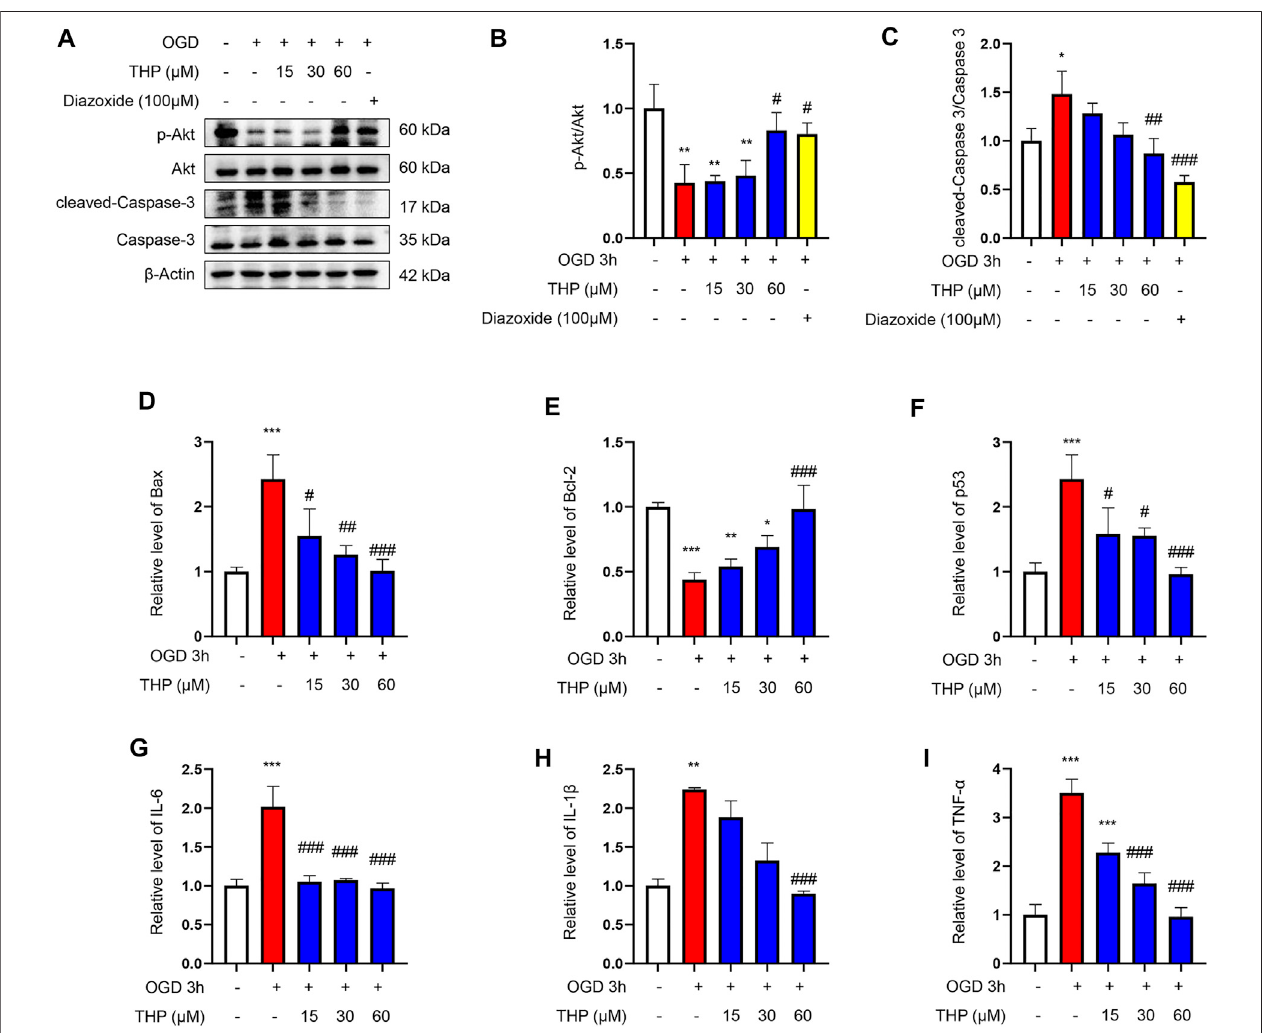
FIGURE 8 | THP was able to suppress apoptosis and the expressions of in fl ammatory factors induced by OGD in H9c2 cells. The cultured cells were treated with different concentrations of THP or diazoxide and stimulated with OGD for 3 h (A – C) The protein expressions of p-Akt, total Akt, cleaved caspase-3, and caspase-3. (D – F) ThemRNA expressions ofapoptosis factors (Bax,Bcl-2, andp53). (G – I) ThemRNAexpressionsofin fl ammatory factors (IL-6, IL-1 β , andTNF- α ).Dataareshown as the mean ± SD. * p < 0.05, ** p < 0.01, *** p < 0.001 vs. control; # p < 0.05, ## p < 0.01, ### p < 0.001 vs. OGD. n = 3 (three independent